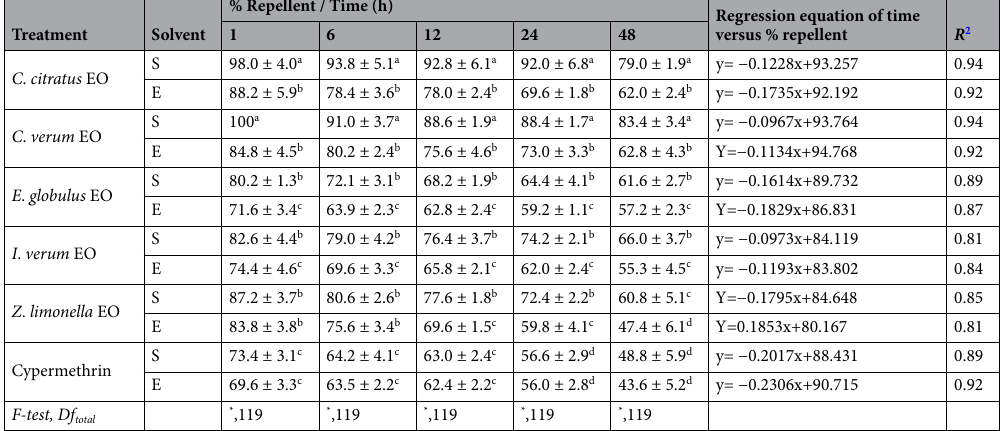
Table 3. Repellent activities against Periplaneta americana adults of 10% solutions of five plant essential oils (EOs) and cypermethrin in soybean oil and in ethyl alcohol. Mean percentage repellent activity within the same column followed by different letters are significantly different at P< 0.05 (ANOVA and Tukey’s post hoc test). S Soybean oil formulation, E Ethyl alcohol formulation, R 2 Regression coefficient, * Significantly different at P <